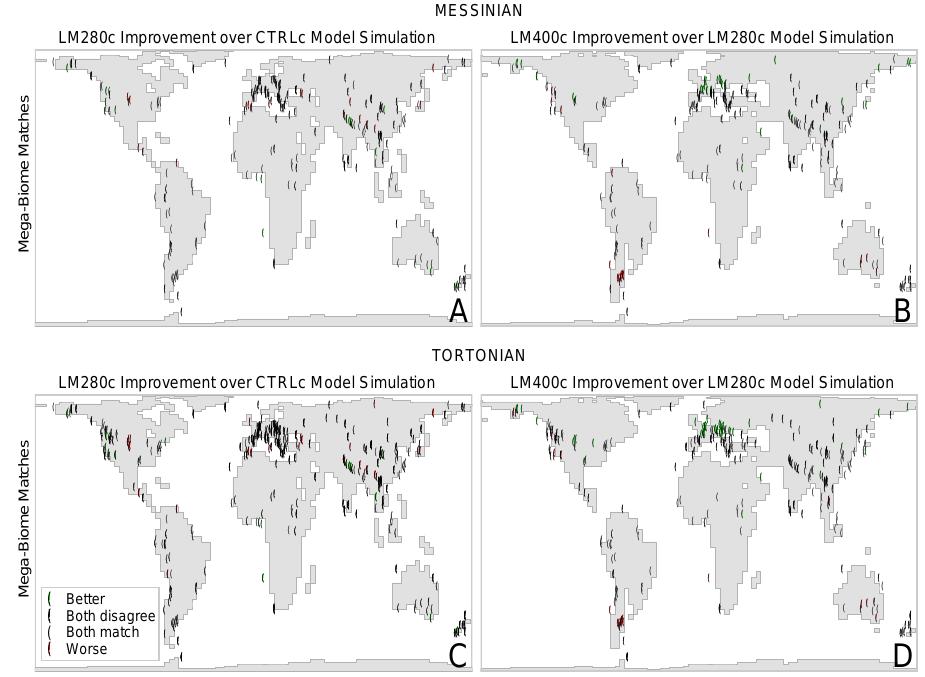
Fig. 16. Improvements in the model–data comparison for megabiomes. Panels (A) and (C) show the improvement that the late Miocene palaeogeography makes to the model–data comparison. Panel (B) and (D) show the improvement that higher CO 2 makes to the model–data comparison. Green circles indicate an improvement; red circles indicate a